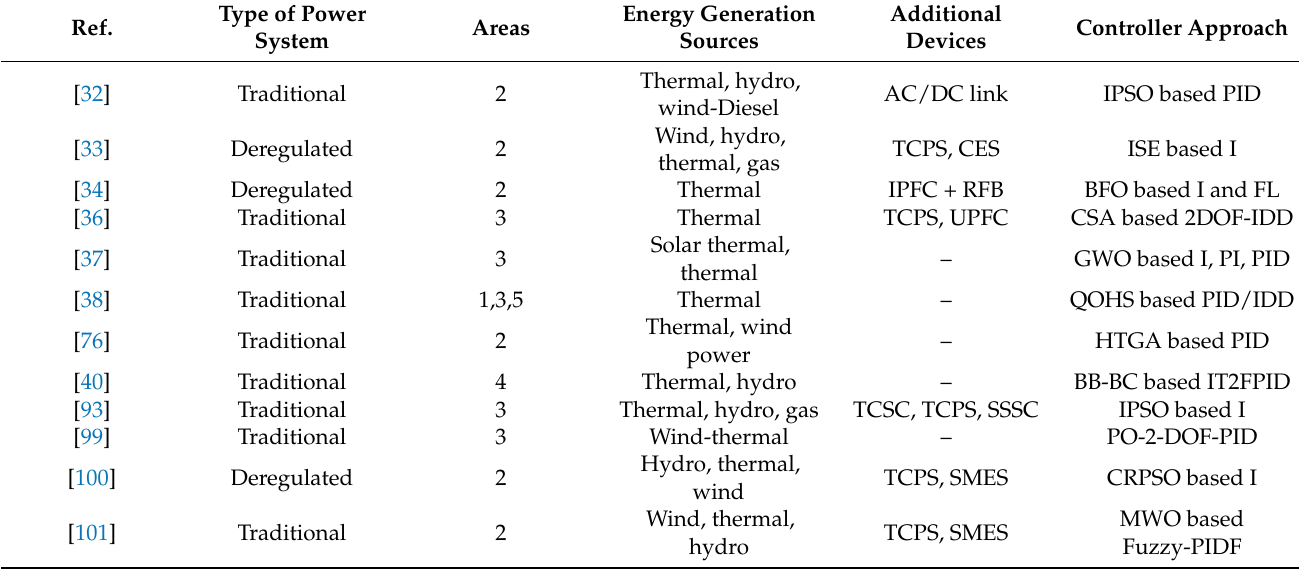
Table 5. Summary of AGC Schemes with/without RES from recent